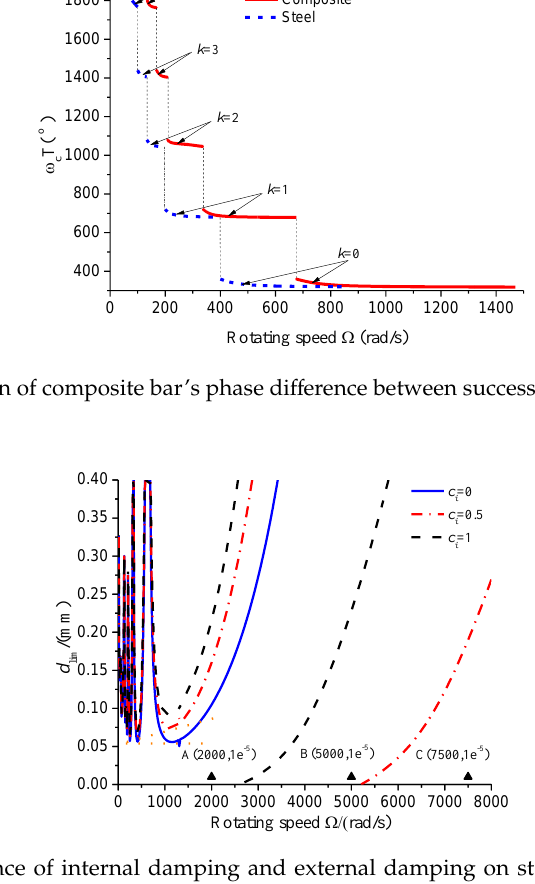
Figure 9. The influence of internal damping and external damping on stable zone for composite milling bar.